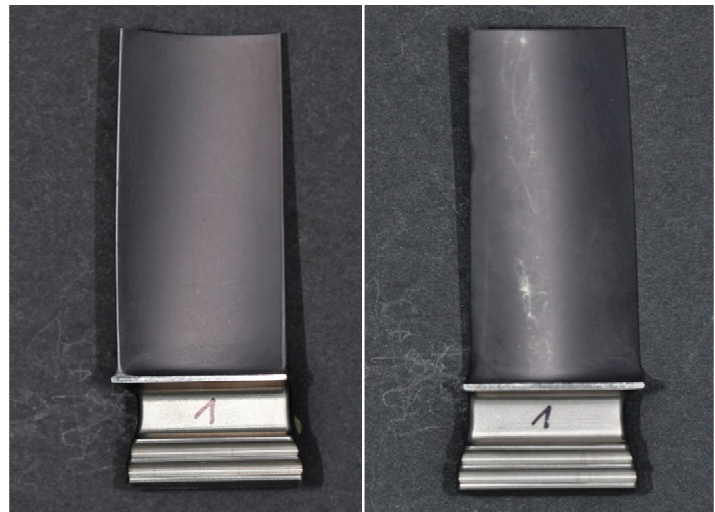
Figure 2. The blade No. 1 concave and convex surfaces (Reprinted with permission from Ref. [2]. 2011, AFIT.).